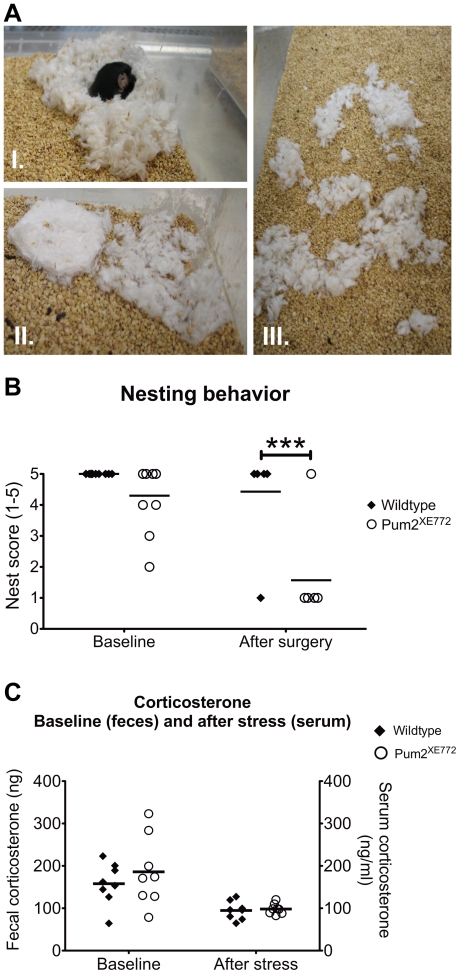
Nesting behavior and stress.(A–B) Nesting behavior. Nestlets were provided at night and nests were scored the next morning. (A) Examples for nest scoring: top left picture show score 5 (perfect) nest with walls higher than the mouse body for more than 50% of its circumference, bottom left picture shows score 2: Nestlet is only partially torn (50–90%), right hand picture shows score 3: less than 90% of the Nestlet is within a quarter of the cage floor area. (B) Pum2XE772 mice have impaired nest building abilities. The baseline effect is further (significantly) enhanced after surgery. (C) Corticosterone analysis in baseline (from feces) and after stress (serum). For baseline measurements, total corticosterone was extracted from feces collected from an 8-hour period. To analyze corticosterone levels under stressed, mice were restrained for 20 minutes and immediately sacrificed to collect blood. There was no significant difference between Pum2XE772 mice and wildtype littermates under either condition (***p<0.001).